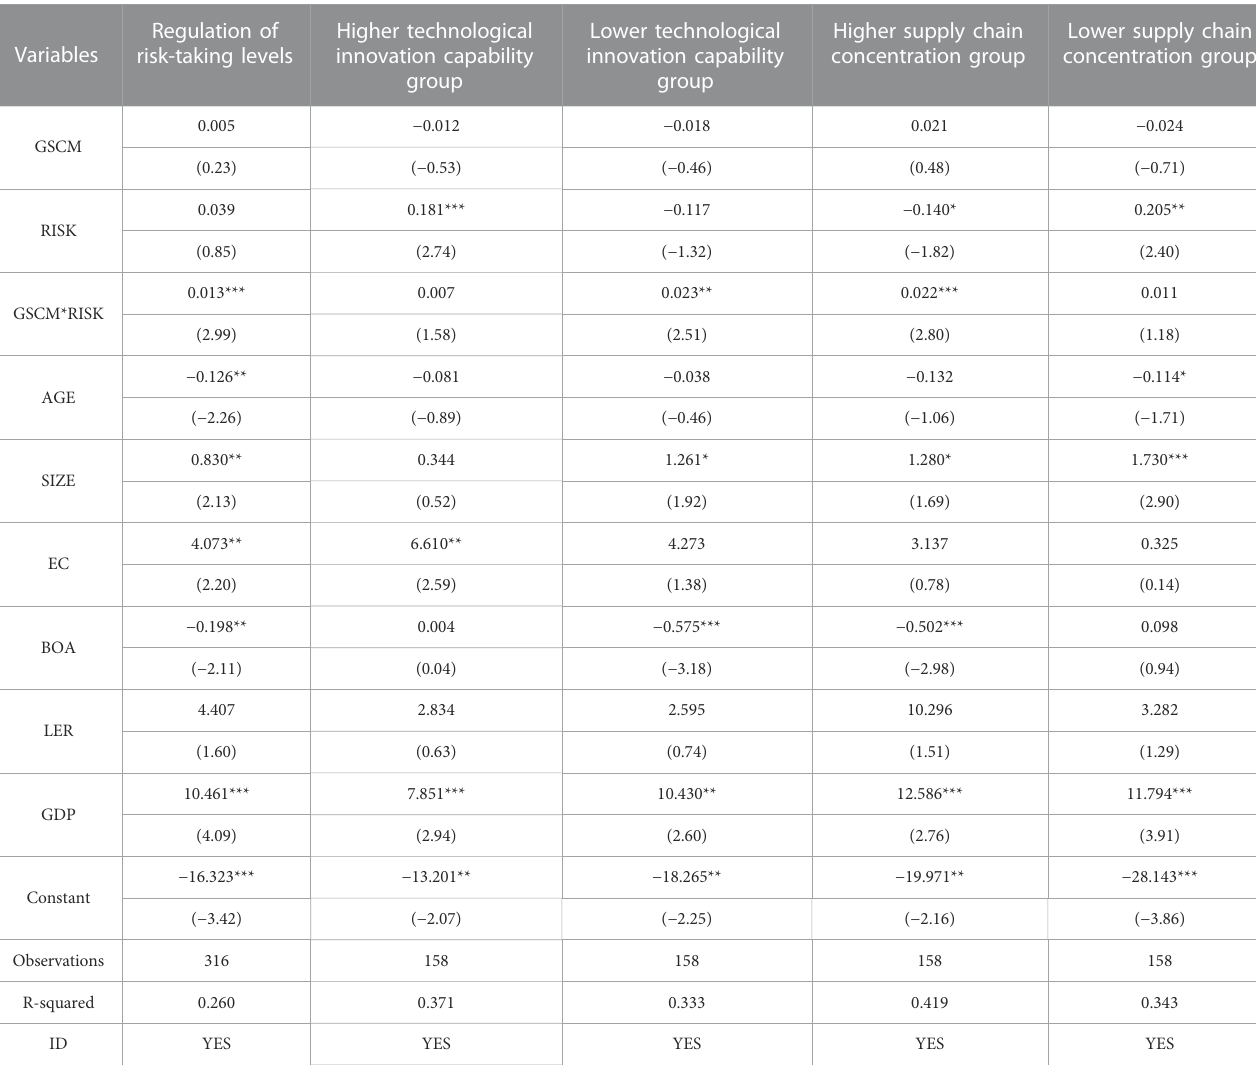
TABLE 5 Moderating effect